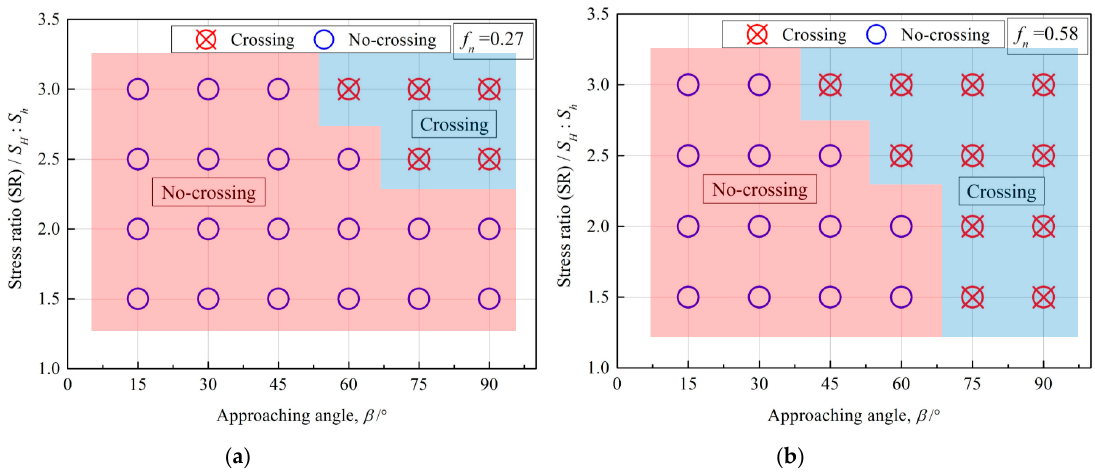
Figure 10. Hydraulic fracture (HF) and fault interaction behavior for the numerical simulations performed under the friction coefficient of the fault: ( a ) f n = 0.27; and ( b ) f n = 0.58. Table 1. Micro-properties used for the simulated model after calibration. PB: parallel bond; SJ: smooth joint.